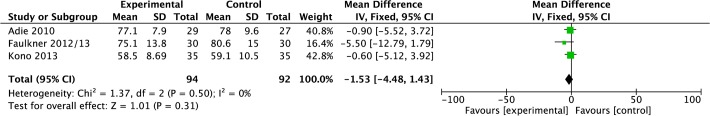
Forest Plot: Weight.